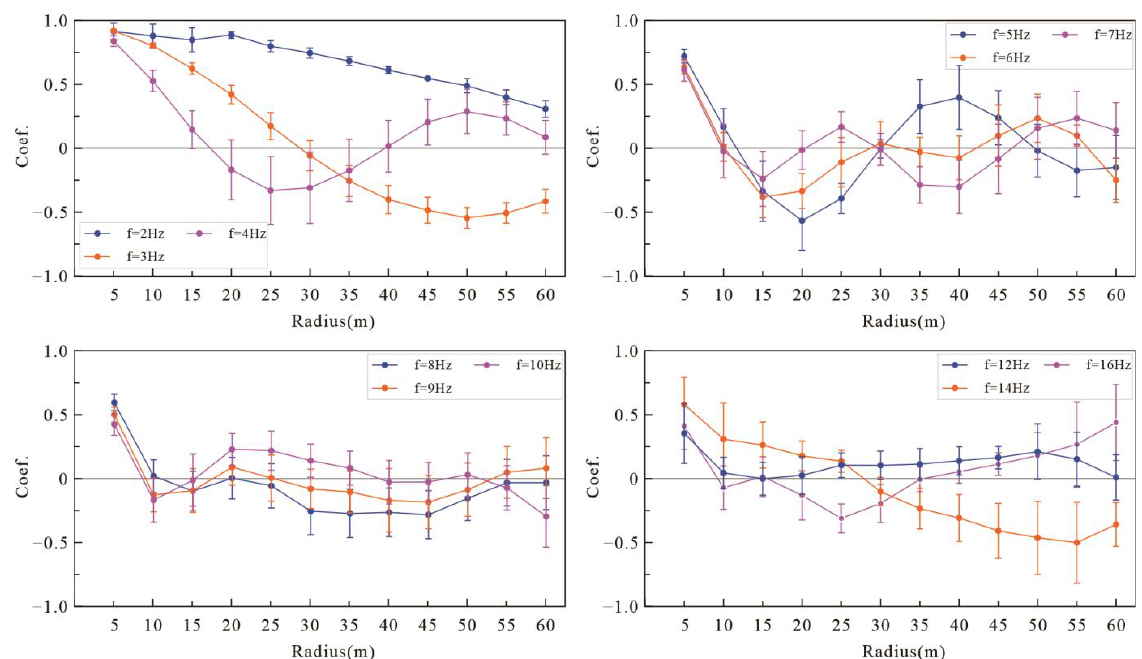
Figure 3. Autocorrelation coefficient of partial frequency at point H32.